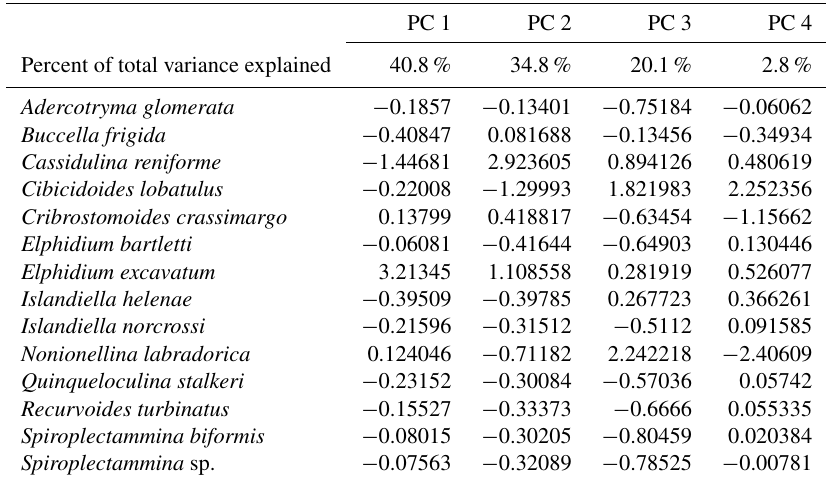
Figure 4. The abundances of selected foraminifera species expressed as percentages (%) of the total assemblage. The foraminiferal taxa were grouped based on their ecological tolerances (see Sect. 5: “Foraminifera as palaeoenvironmental indicators”). MWP: Medieval Warm Period; LIA: Little Ice Age; MW: modern warming. The time ranges of MWP, LIA and MW are presented after Majewski et al. (2009). Table 2. PC scores and percent of total variance explained by four-factor principal component analysis. The contribution of each analysed species is shown, and species significant for particular assemblages are marked in